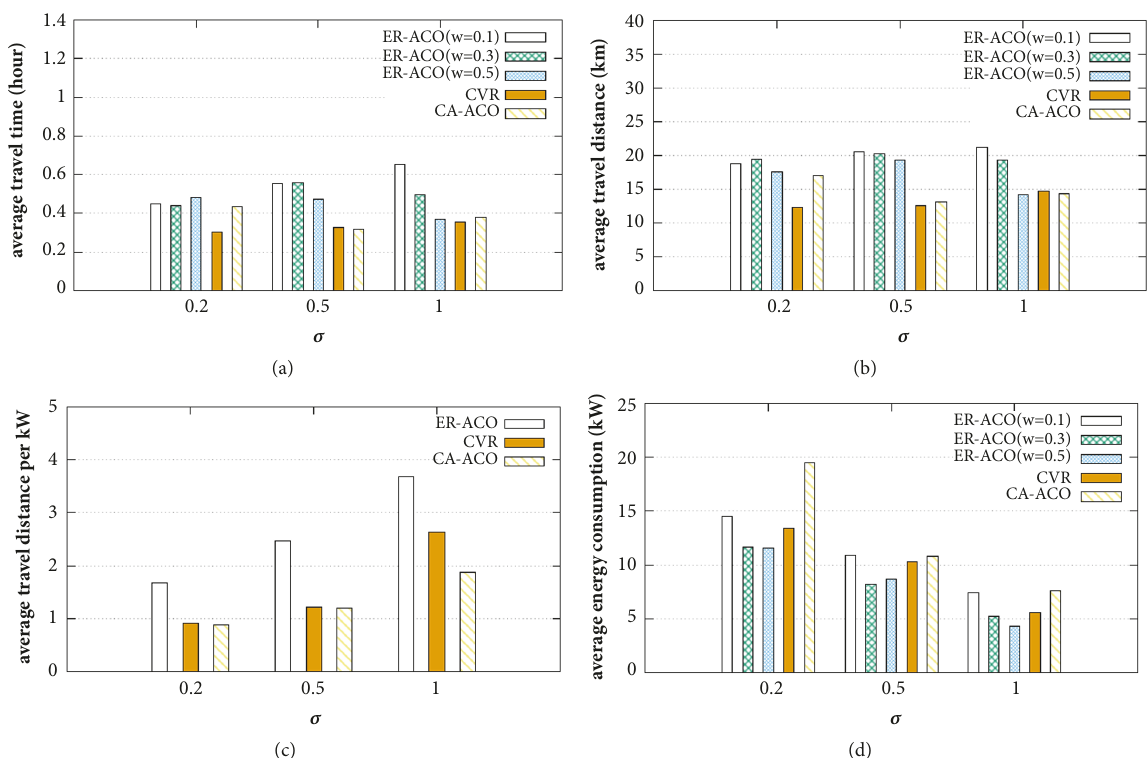
Figure 4: Performance comparison with varying road gradients in a Gaussian distribution: (a) travel time, (b) travel distance, (c) travel distance per unit of energy consumption, and (d) energy